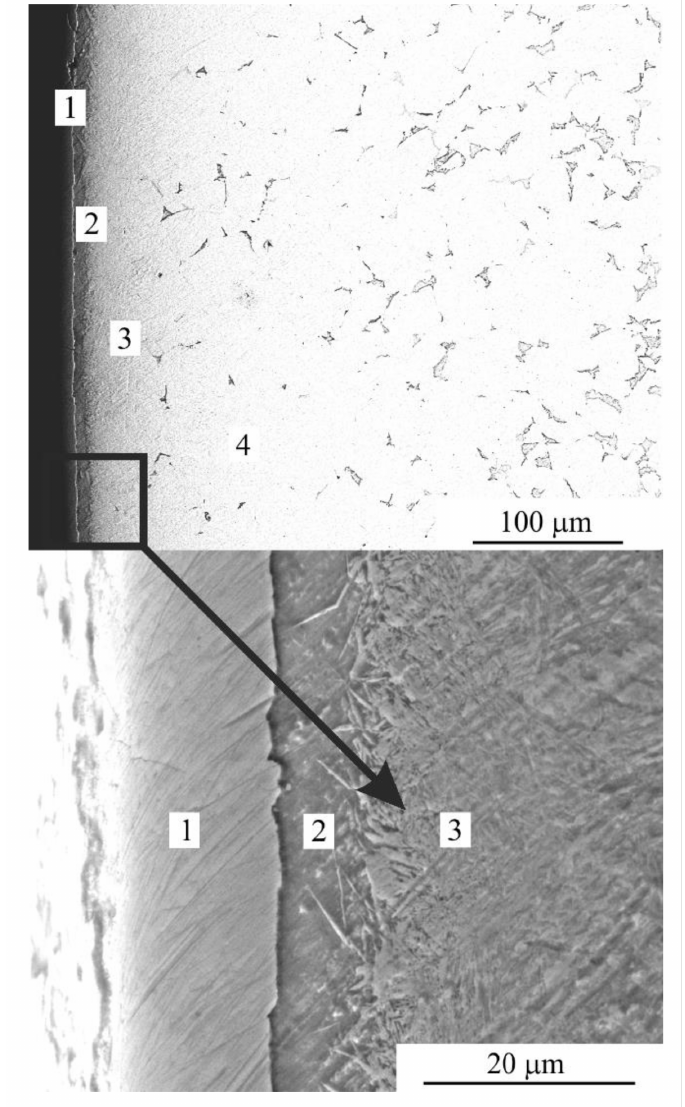
Figure 4. SEM image of cross-section of the steel surface after PEN. 1—oxide layer; 2—nitride- martensite layer; 3—martensite layer; 4—initial pearlite-ferrite structure.